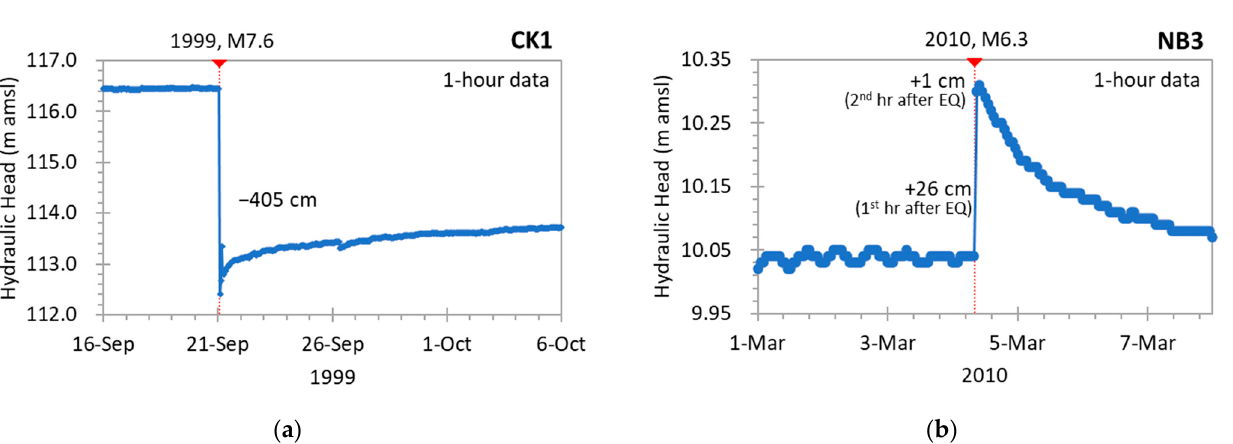
Figure 5. Post-seismic changes in well water level recorded in one hour frequency (the hydraulic head is plotted as the elevation above the mean sea level (m amsl): ( a ) recovery of a coseismic fall in well CK1 after the 1999 M7.6 earthquake; ( b ) recovery of a coseismic rise in well NB3 after the 2010 M6.3 earthquake.